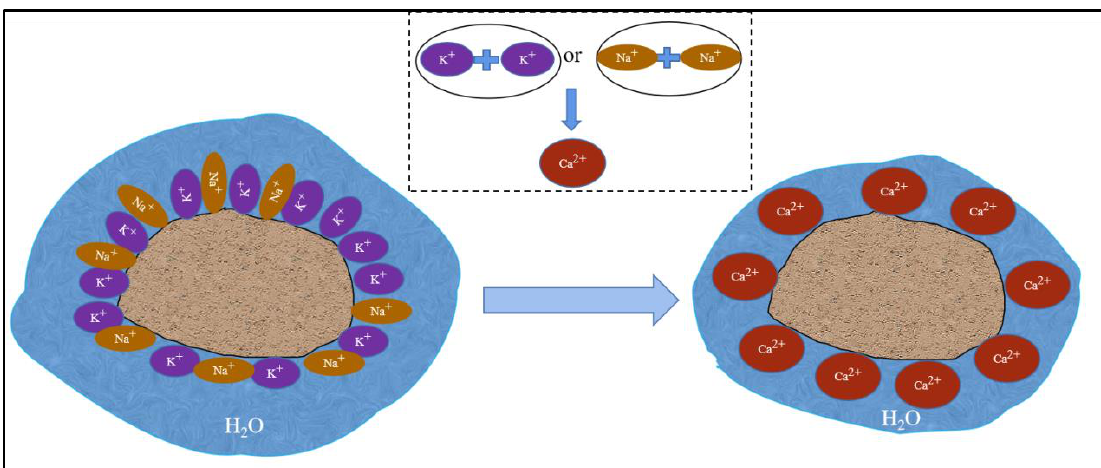
Figure 16. Ion exchange reaction.